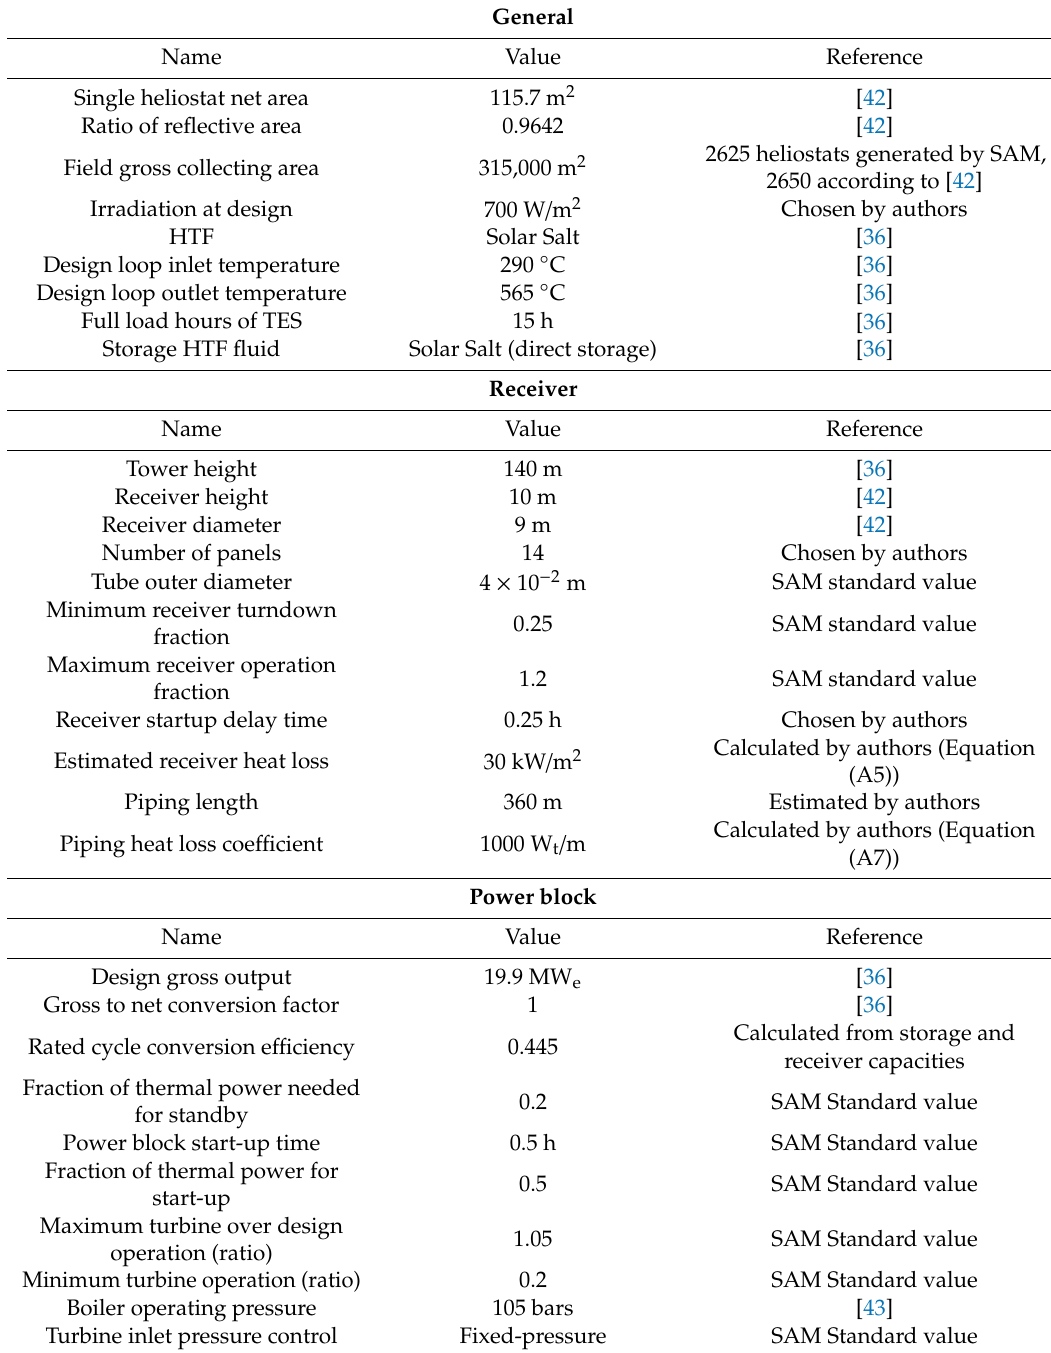
Table A1. Input parameters for the SAM simulation of the Gemasolar thermosolar power plant during one year (from 1 July, 2017 to 30 June,